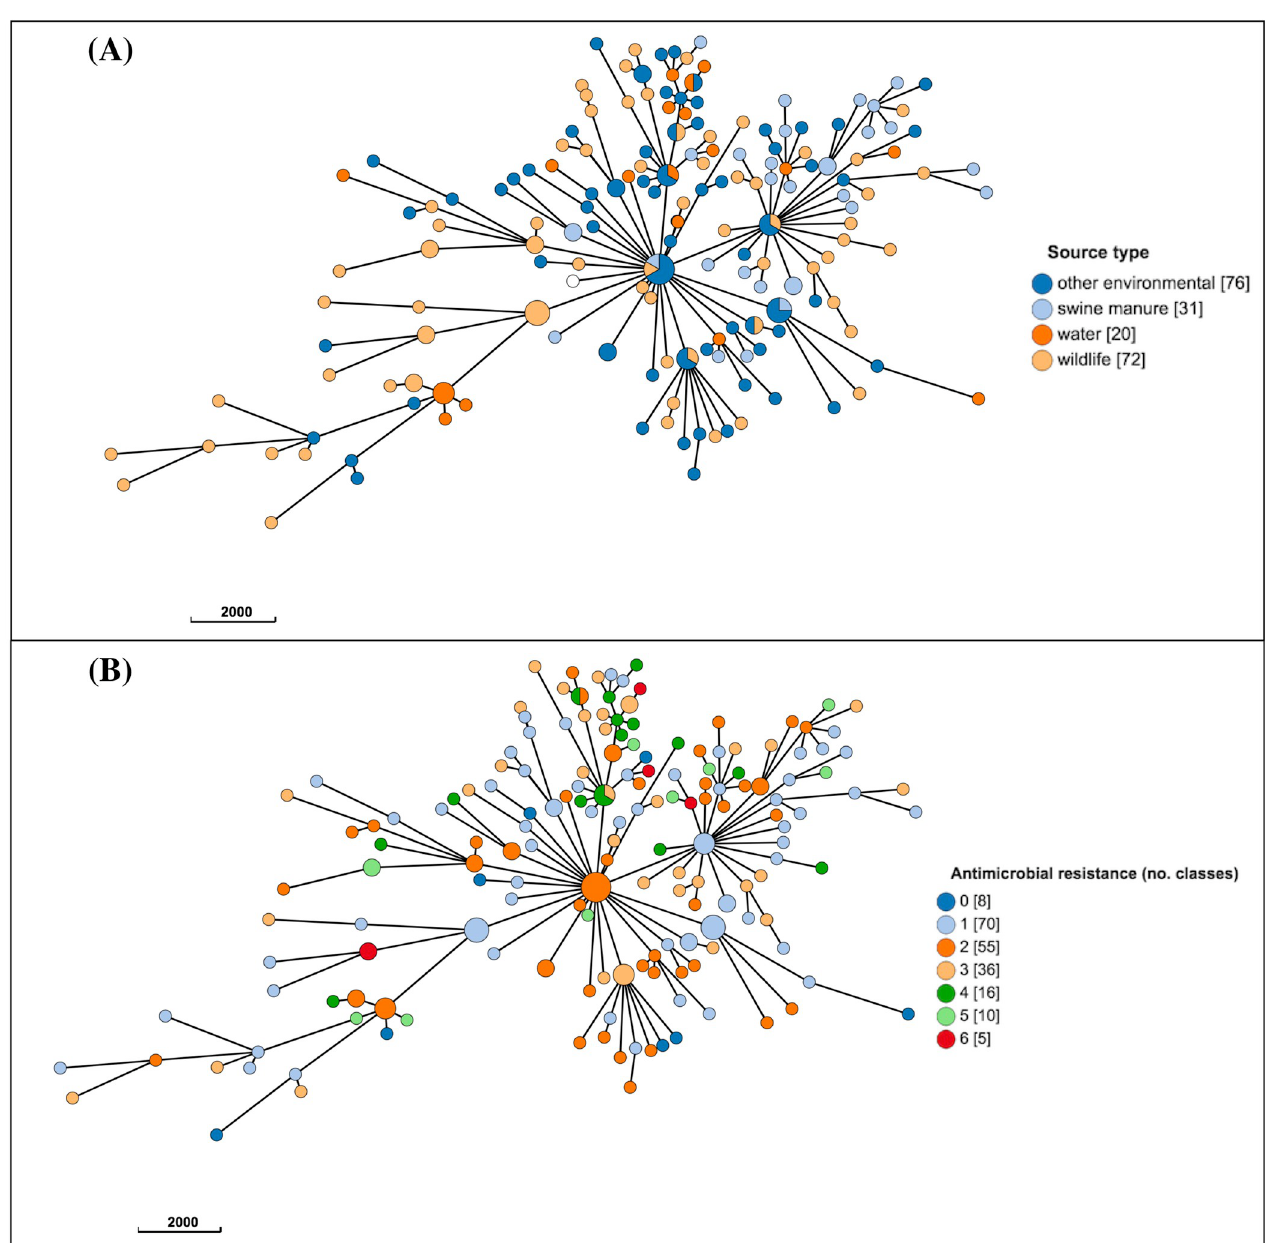
Fig 3. Population structure of 200 Escherichia coli isolates (dataset A) from wildlife, swine manure pits, and environmental sources in southern Ontario based on 2513-loci cgMLST scheme from Enterobase. Minimum spanning tree created using k = 50 clustering threshold in GrapeTree . (A) Distribution of source types. (B) Antimicrobial resistance by number of drug classes. Frequency counts are in square brackets. Bubble size is proportional to the number of isolates in each cluster, and each cluster contains isolates differing at a maximum of 50 cgMLST loci. AmpC-producers, ESBLs); ten E . coli isolates contained bla , and one raccoon E . coli iso- CMY-2 late contained a bla . Of the isolates containing bla , two were multi-drug resistant TEM-35 CMY-2 (MDR; 3+ antimicrobial classes) isolates collected from raccoons, and all but two of these iso- lates were obtained from raccoons captured in conservation areas. One of the two MDR E . coli isolates from raccoons had the phenotypic resistance pattern